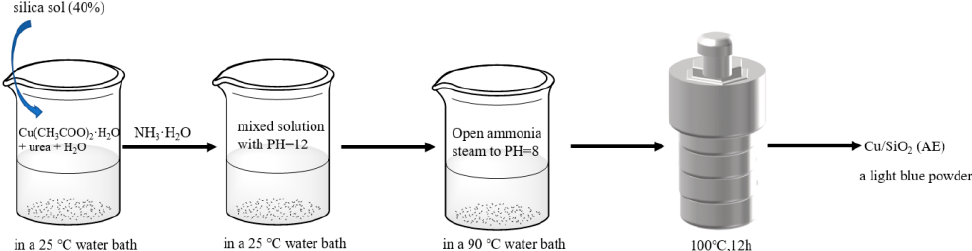
Figure 9. Preparation of Cu/SiO 2 (AE) by ammonia evaporation method.